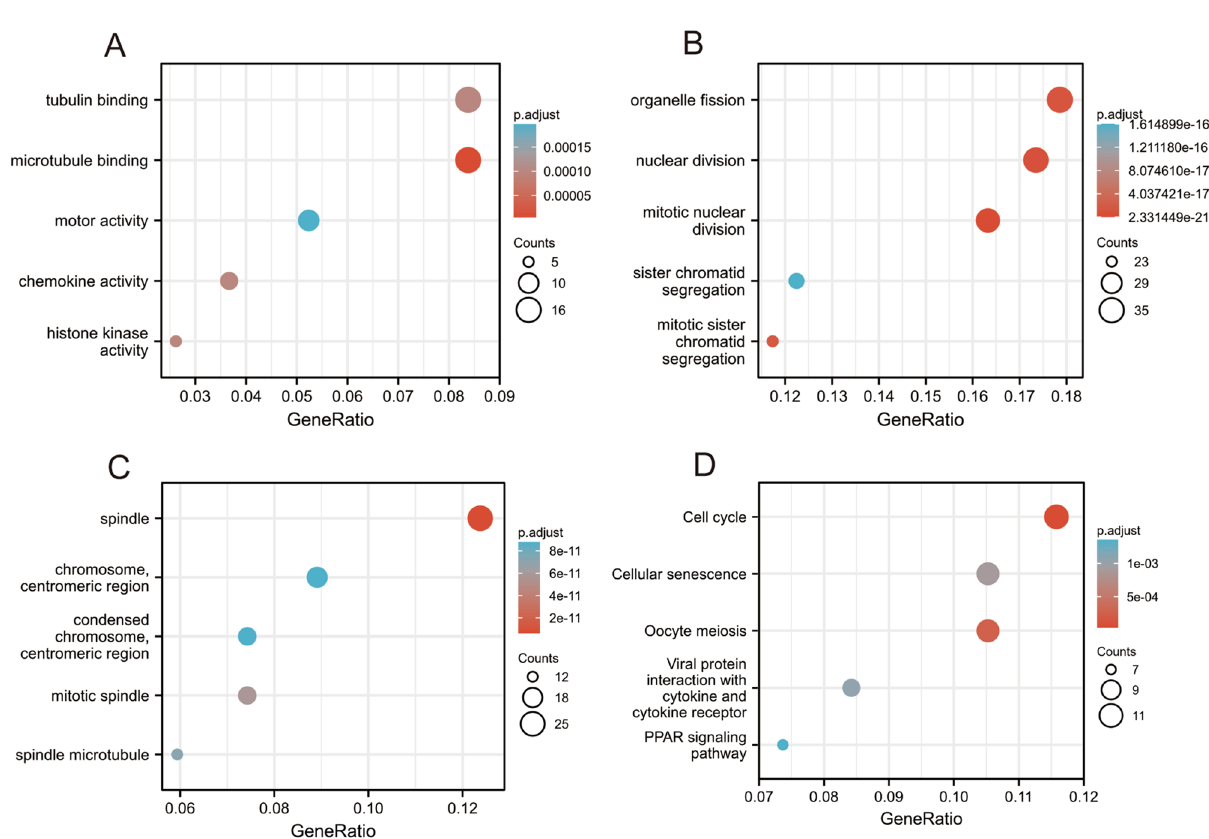
Figure 3. GO/KEGG enrichment analysis was used to determine the difference between high and low levels of RAB7A expression in TCGA patients. ( A ) GO terms enriched in the ‘Molecular Function’ category; ( B ) GO terms enriched in the ‘Biological Processes’ category; ( C ) Enriched GO terms in the “cellular component” category; ( D ) Annotations of KEGG pathways (Sourced from www. kegg. jp/ kegg/ kegg1. html). The X-axis indicates the percentage of DEGs, while the Y-axis indicates the various categories. Different colors denote various qualities, while various sizes denote the amount of